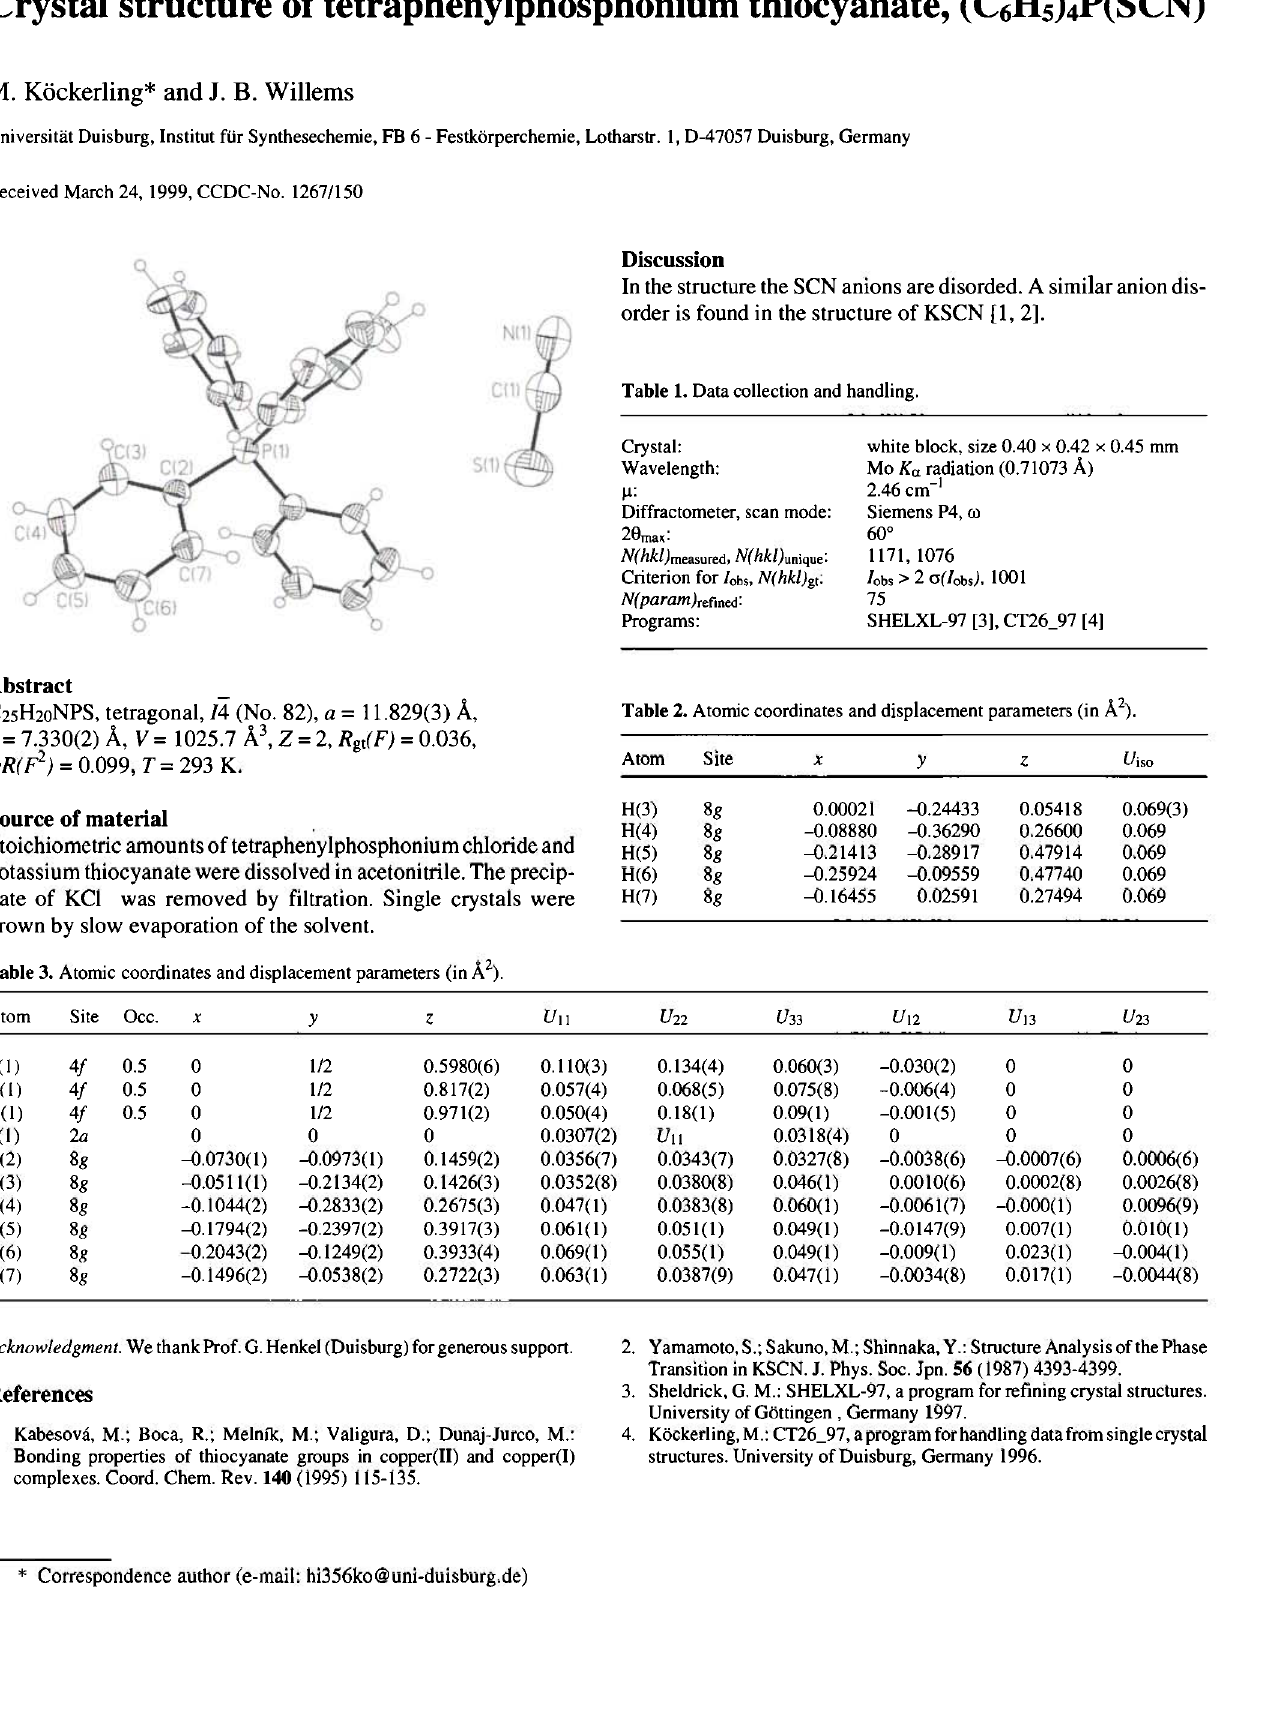
Table 1. Data collection and handling.